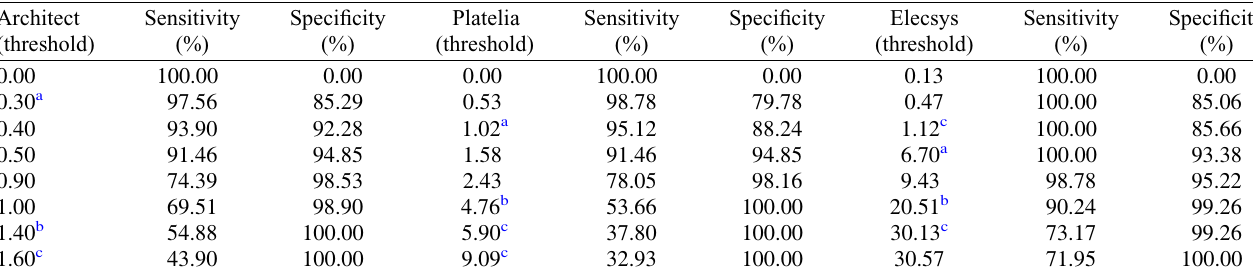
Table 4. Sensitivities and speci fi cities of Architect, Platelia and Roche according to the threshold. Architect